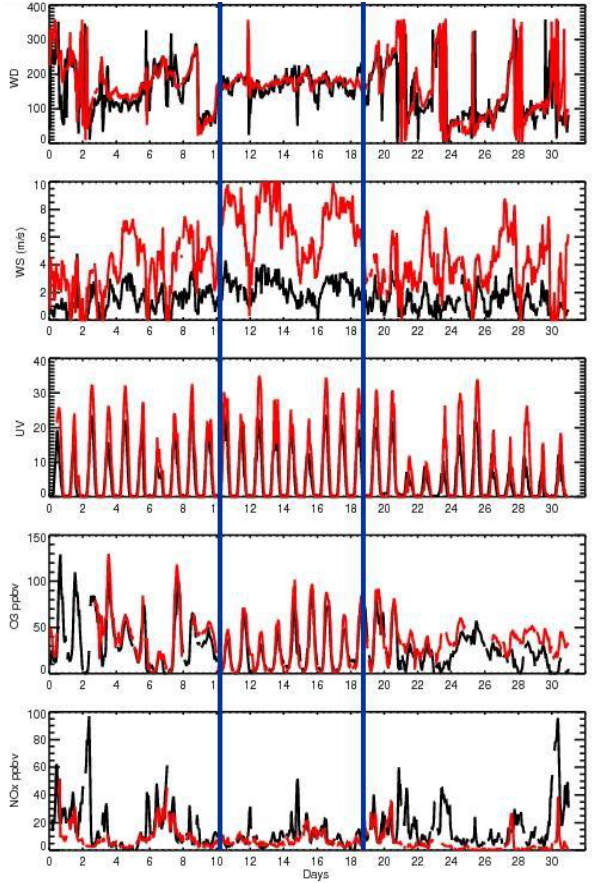
Fig. 5. General meteorological and chemical conditions at 2 stations (an urban site (PD) shown in black lines and a rural site (CM) shown in red lines) for wind direction, wind speed, UV, O 3 , and NO x in Shanghai during July 2009. The blue lines indicate that between 10 and 18 July, 2009, the wind directions were generally from the south or southwest, and the air from the forests can be transported to the city of Shanghai.